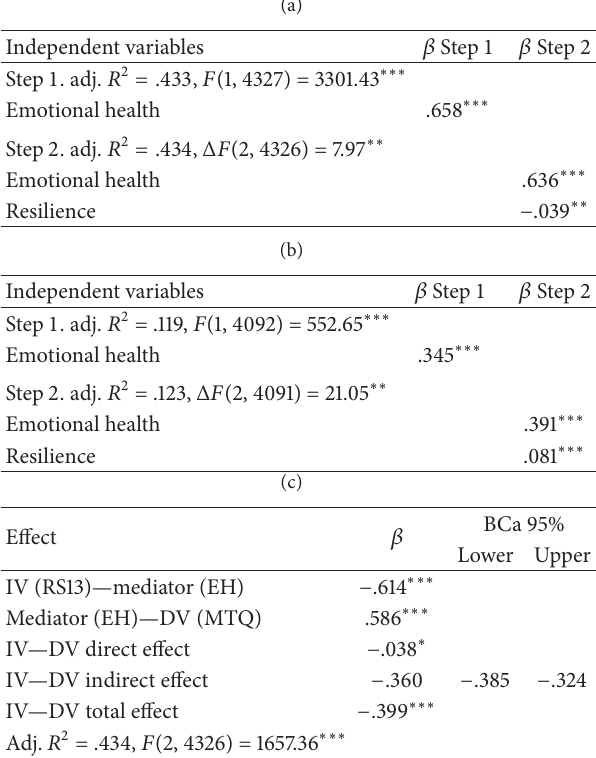
Table 3: (a) Results of regression analysis 1 with MTQ as depen- dent variable. (b) Results of regression analysis 2 with T-NRS as dependent variable. (c) Results of mediation analysis with MTQ as dependent